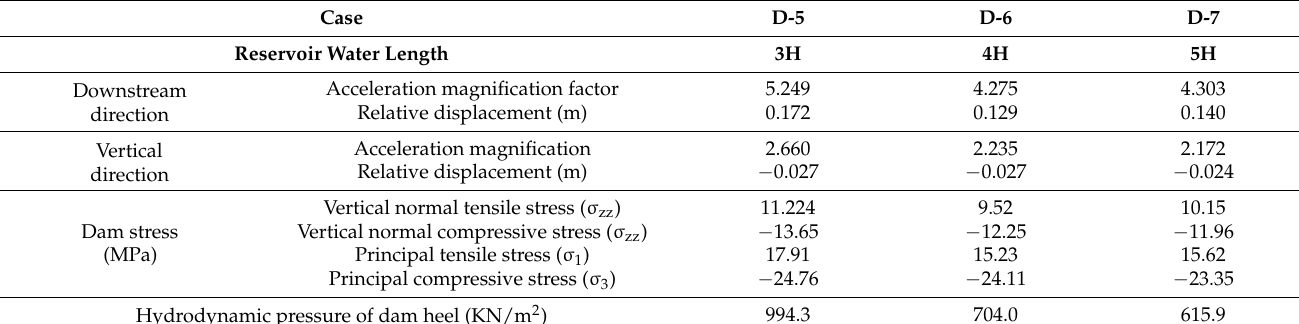
Table 9. The extreme values of the dam dynamic response at different reservoir water